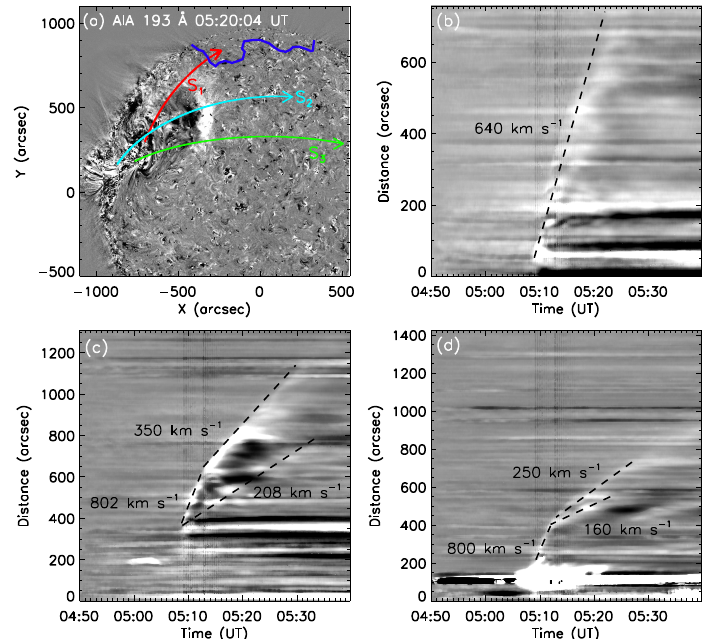
Figure 4. Panel ( a ): AIA base-difference image at 05:20:04 UT, where the blue line marks the boundary of the polar coronal hole. Three slices (S 1 , S 2 and S 3 ) are selected in order to plot the time-distance diagrams of the AIA 193 Å intensity, which are displayed in panels ( b – d ),